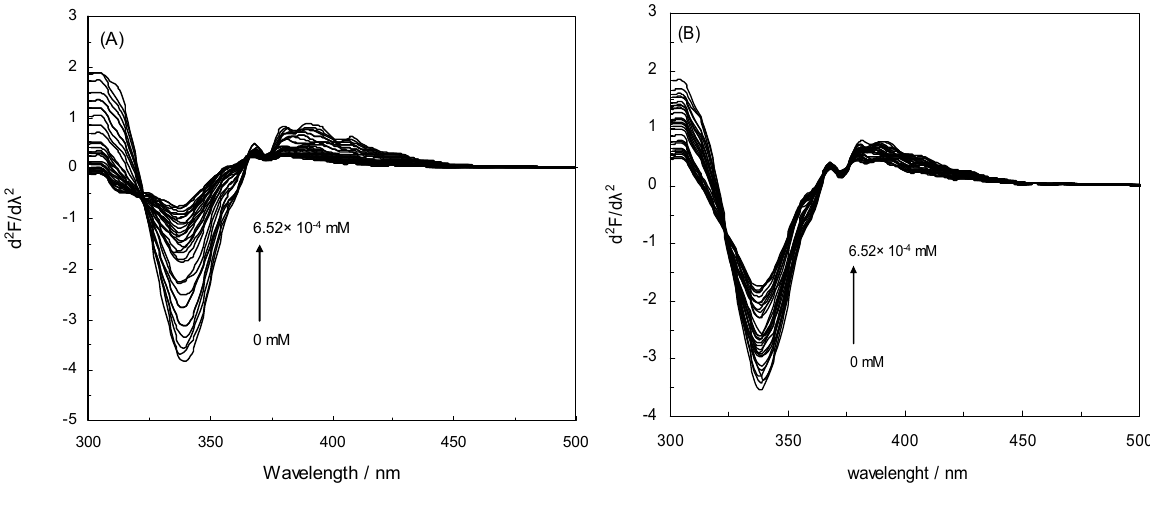
Figure 7. Second derivative fluorescence of HSA-NRF in the absence and presence of EMFs. ( A ) The HSA-NRF system in the absence of an EMF; ( B ) HSA-NRF in the presence of an EMF (100 Hz/2.4